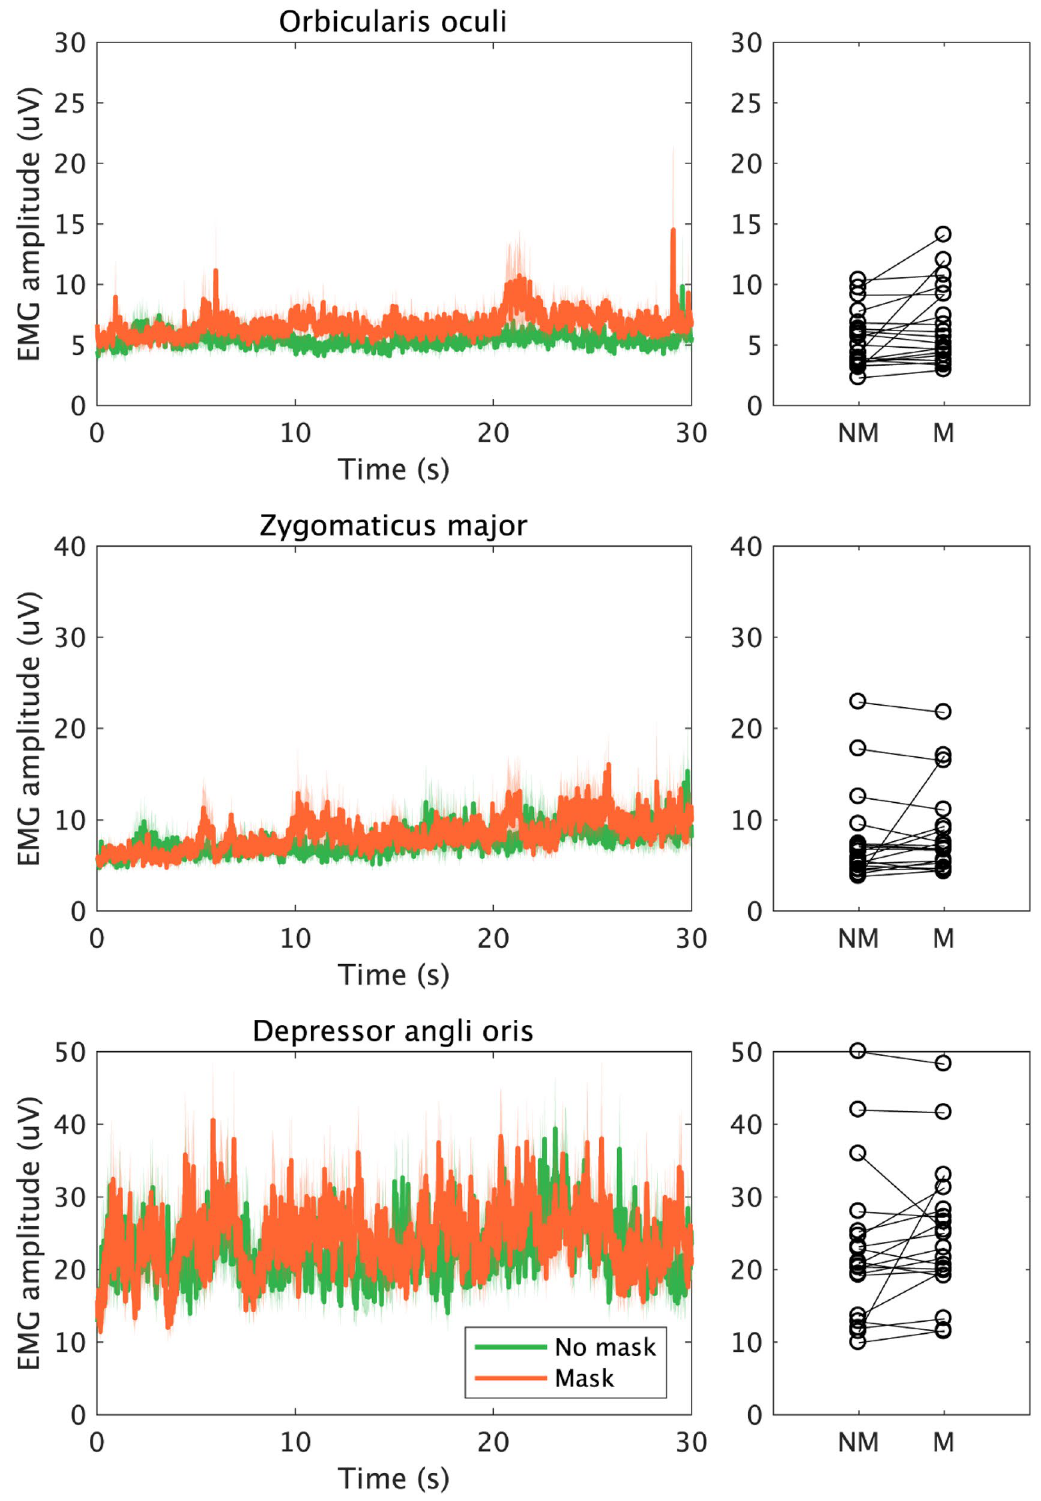
Figure 5. EMG signal measured over orbicularis oculi, zygomaticus major, and depressor anguli oris, during the talking task (30 s). Plots and colours are the same as in Fig.